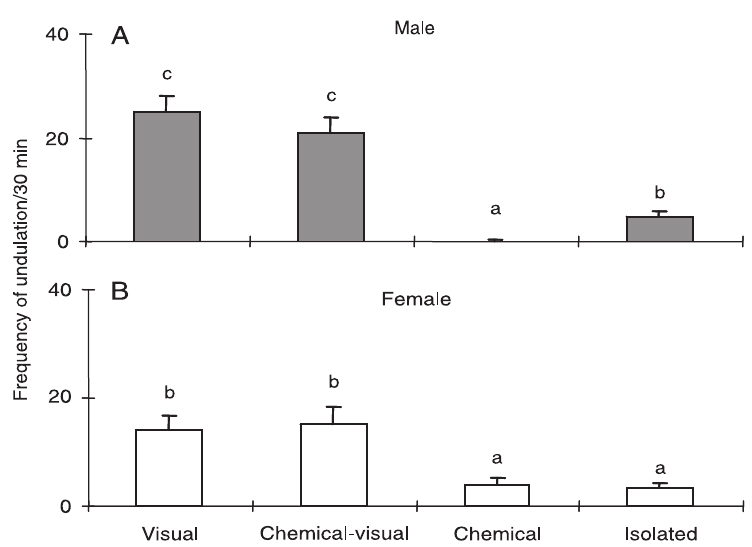
Figure 1. Undulation frequency of males and females under four sensorial condi- tions (N = 14 pairs in each condition). Data are reported as means ± SEM. Different letters indicate statistically significant differences compared with other groups (P < 0.05, two-way ANOVA followed by the LSD